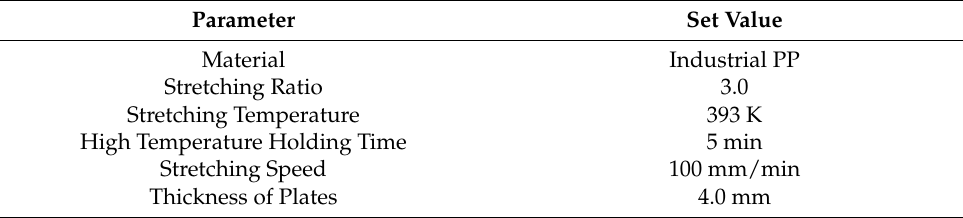
Figure 2. Pre-punched sheet of a triaxial geogrid. ( a ) Clamping area of pre-punched sheet, ( b ) process parameter diagram of the structure of the pre-punched sheet. Table 1. Process parameter of